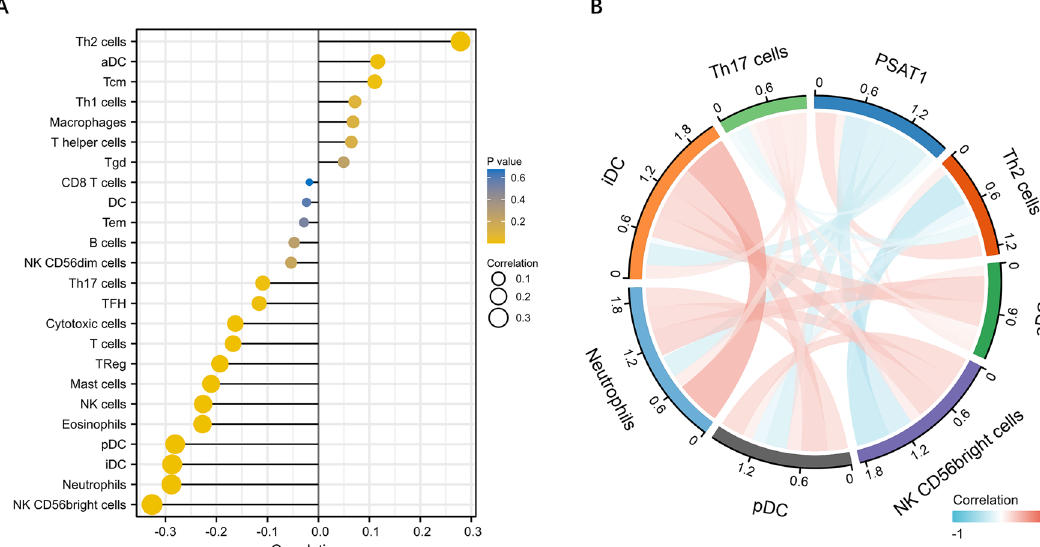
Figure 5. ssGSEA of PSAT1 in UCEC. ( A ) Correlation between the relative abundances of 24 immune cells and PSAT1. The size of dots represents the absolute value of Spearman R. ( B ) The immune cells with clear correlation were visualized in the form of a chord